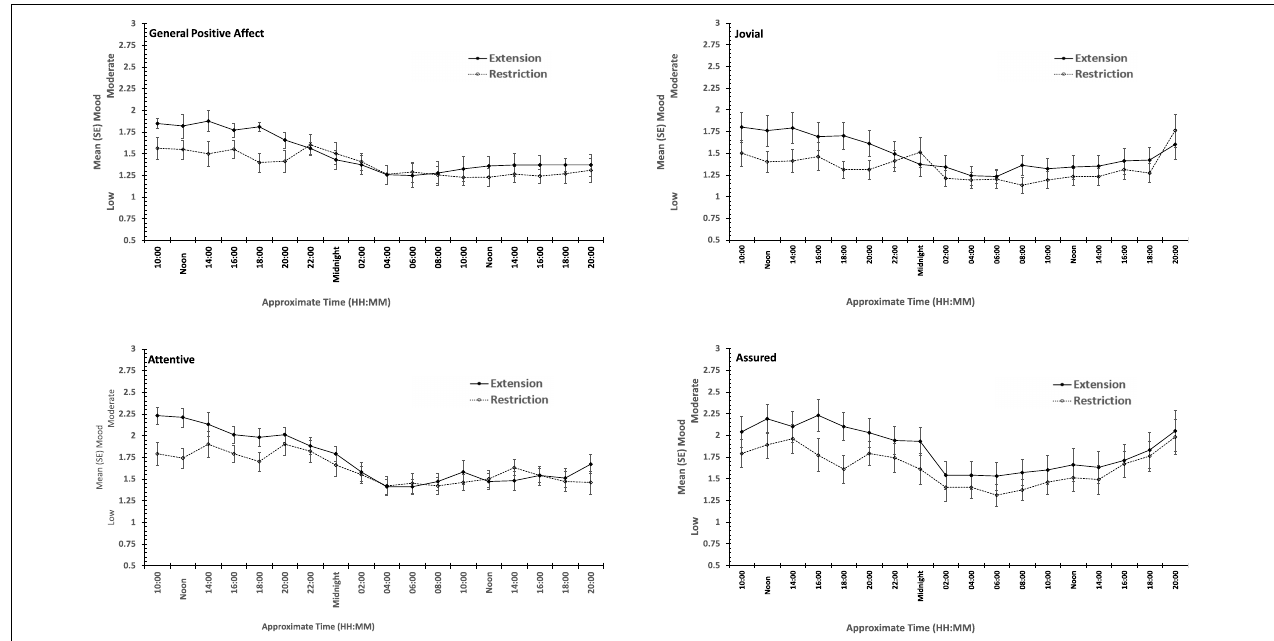
FIGURE 6 | Effects of prior sleep restriction and extension on Positive Mood (General Positive Affect, Assuredness, Joviality, Attentiveness) across 38 h of